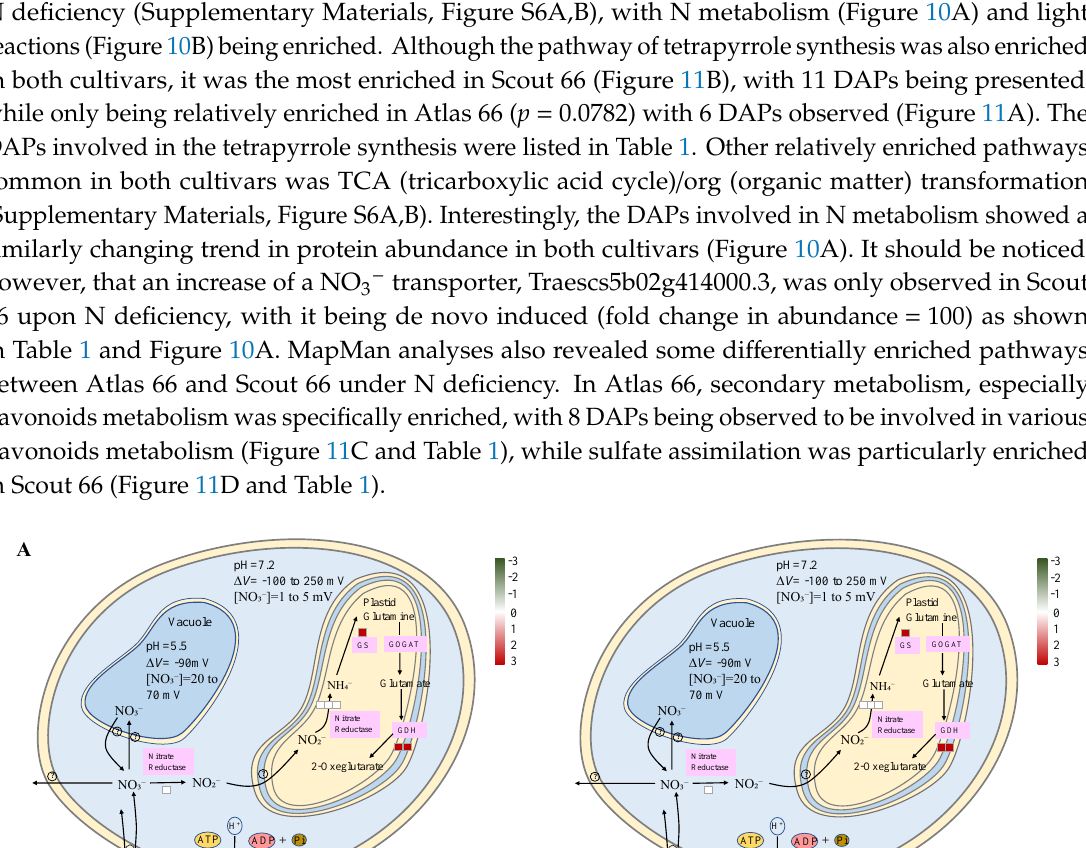
metabolism and light reactions. From left to right are Atlas 66 and Scout 66, and all of them are analyzed in and exported from MapMan software and the image quality was further improved